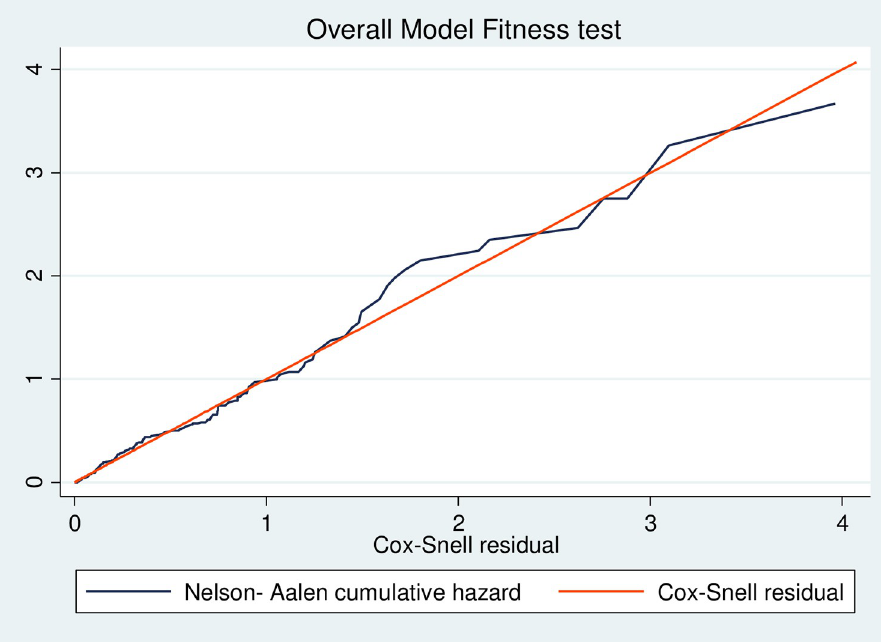
Fig 3. Model adequacy for incidence of mortality and its predictors of breast cancer patients at the referral hospital in northwest Ethiopia.